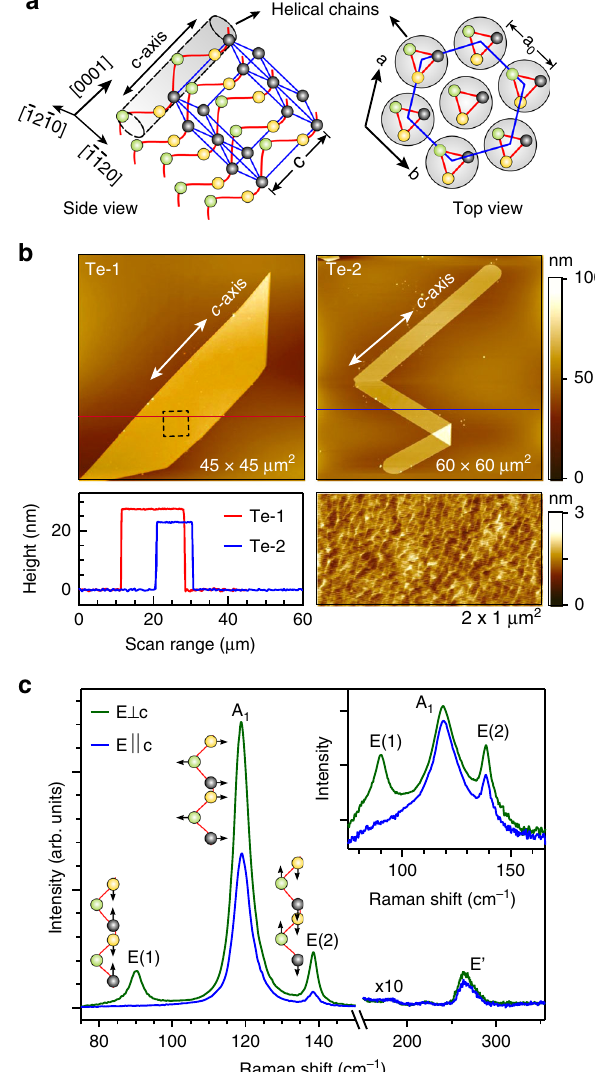
Fig. 1 Structure and morphology of Te nanosheets. a Crystal structure of trigonal Te (left image) in which spheres of different colors represent Te atoms within the helical chains (shaded region) arranged in a hexagonal array along the growth direction, i.e., the c -axis. Pattern with blue lines shows a hexagonal unit cell along [0001]. The right image is the top (surface) view of the crystal from the [0001] direction, showing ab – plane (basal plane) and surface lattice parameter ( α 0 ). b AFM topographies of the Te nanosheets used for optical measurements (symbolized by Te-1 and Te-2) and their cross section pro fi les (red and blue lines). Close-up height scan on Te-1 (dotted rectangle) is shown on bottom right, which exhibits a relatively smooth surface with an average corrugation of <2 nm. c Representative Raman spectra acquired on these samples using a 633-nm laser excitation source with two perpendicularly polarized con fi gurations with respect to the c -axis, i.e., E jj c and E ? c . Three prominent optical modes, as indicated by A 1 , E (1), and E (2) modes, respectively, are detected with E ? c while only A E (2) modes are clearly visible with E jj c . Inset shows 1 and a log scale plotting of the data, showing that the E (1) mode is symmetry forbidden for E jj c . A weak second order harmonic of E -mode is seen in the spectra and indicated by the symbol E ′